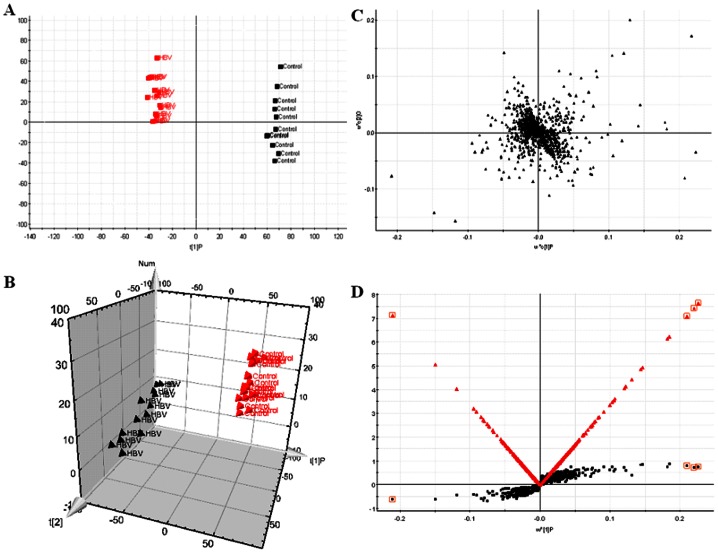
Metabolomic profiling of HBV.OPLS-DA model results for HBV group in negative mode (A). 3-D of OPLS-DA model for HBV group (B). Loading plot of OPLS-DA of HBV in positive mode (C). Panel D shows the combination of S- and VIP-score plots constructed from the supervised OPLS analysis of urine (ESI− mode).